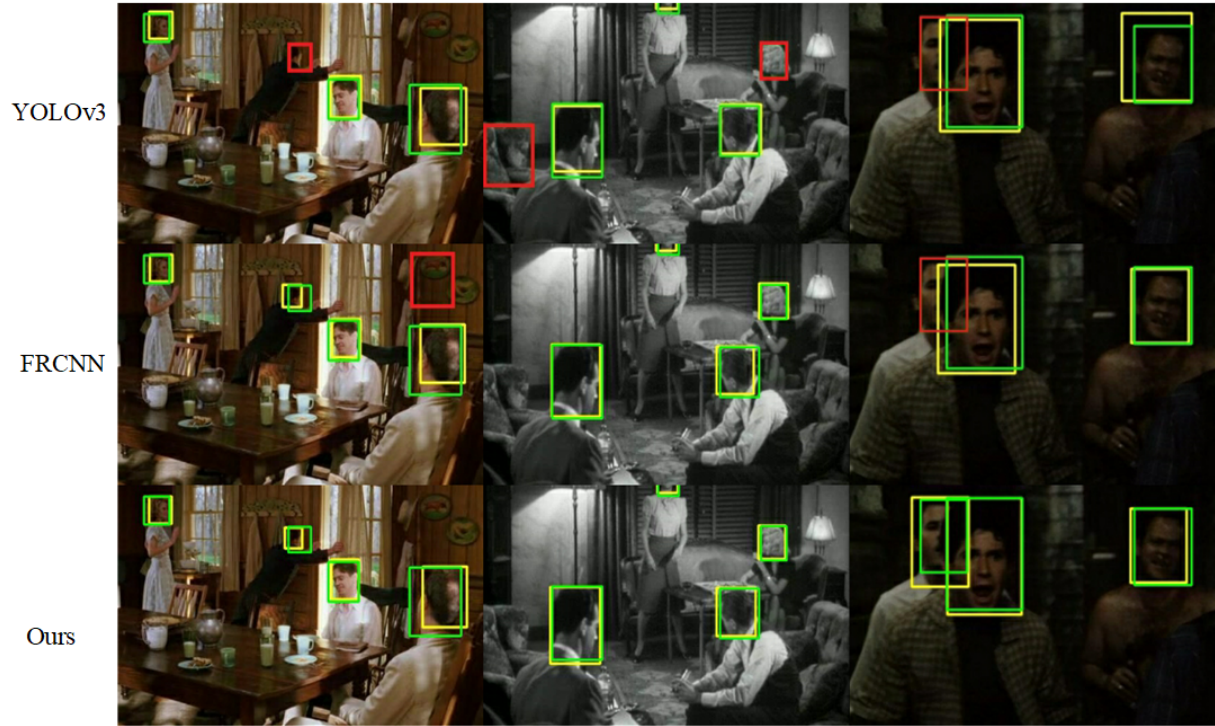
Figure 12. Qualitative results with different methods on the HollywoodHeads